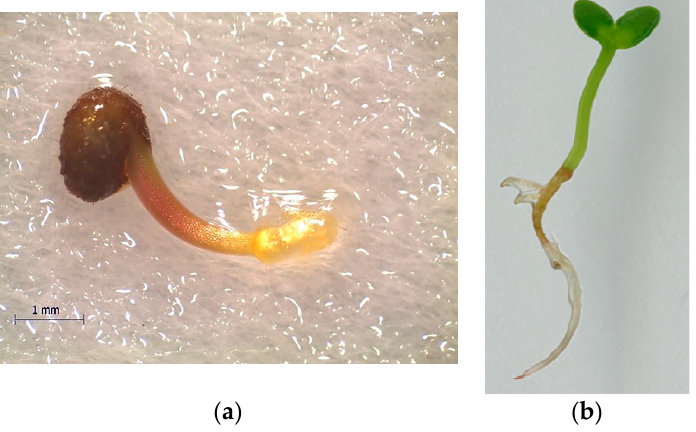
Figure 3. Germination images of Salicornia bigelovii seeds with FW: ( a ) 3 DAS, ( b ) 60 DAS.The germination percentage (GP) and the Germination rate index (GRI) at 20 days after sowing (DAS) were calculated according to Al-Mudaris [37] (Equations (1) and (2)).